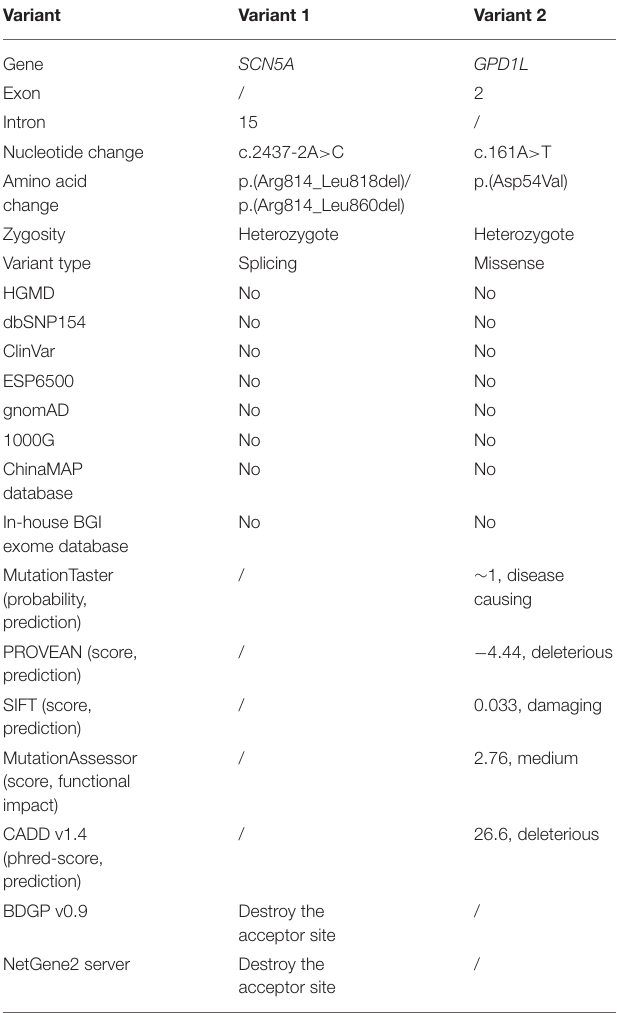
TABLE 2 | Identification of variants in the